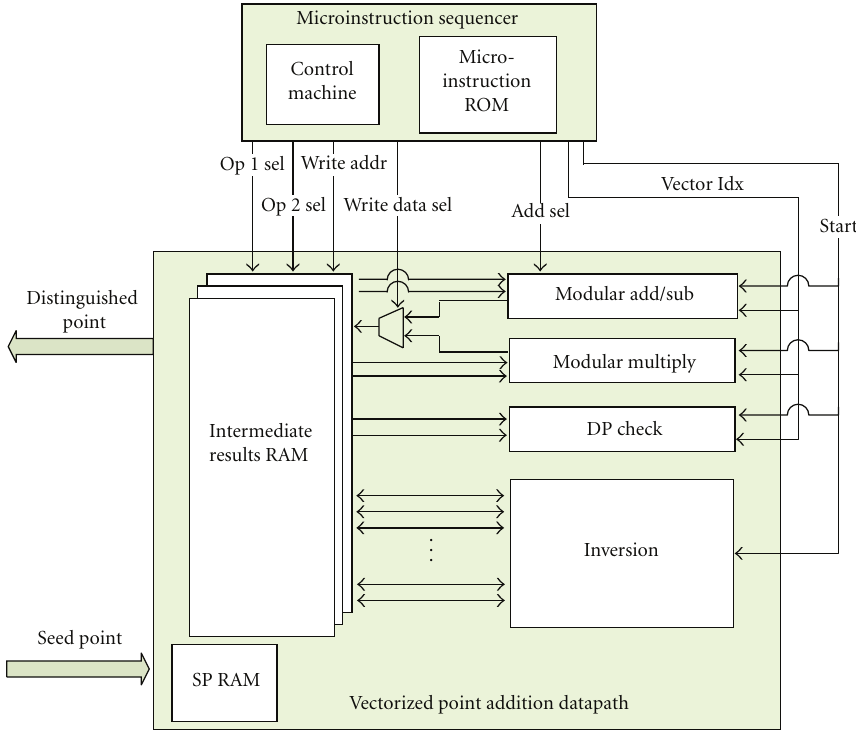
Figure 7: Vectorized point addition datapath with microinstruction